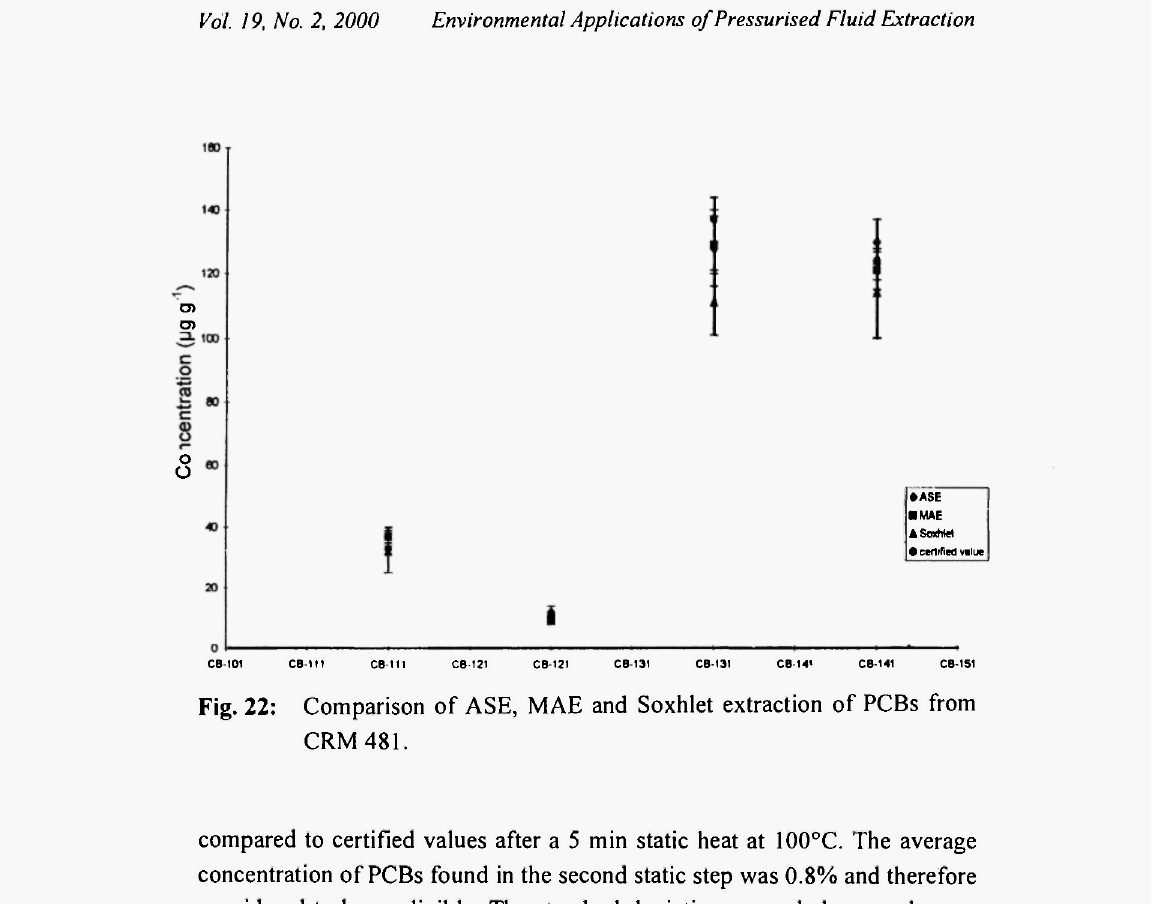
Fig. 22: Comparison of ASE, MAE and Soxhlet extraction of PCBs from CRM